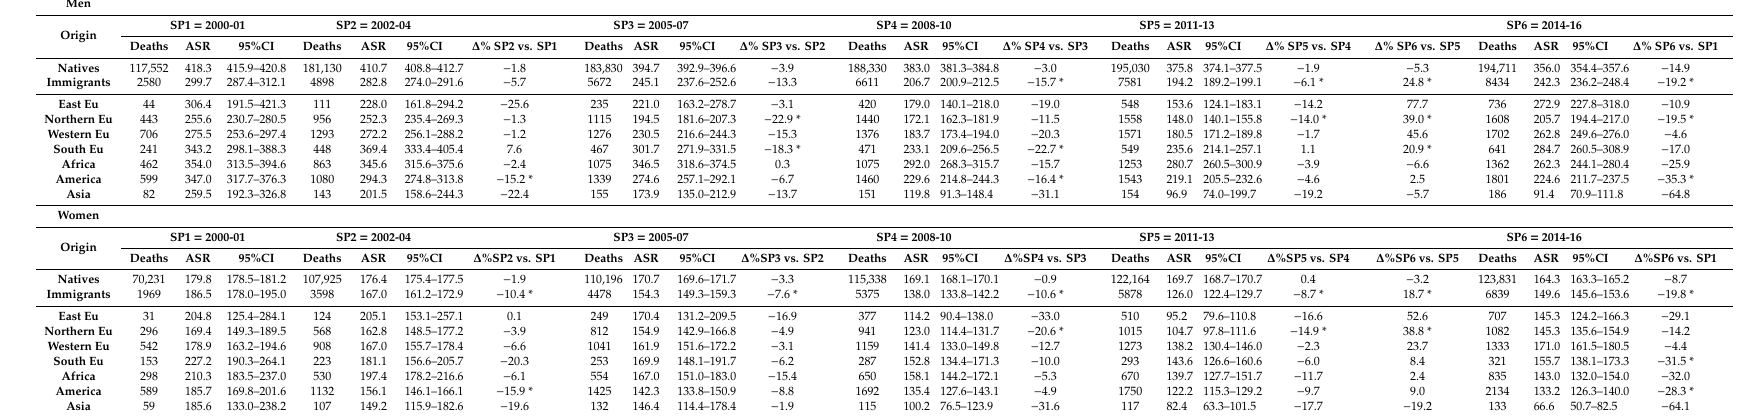
Table 1. Age-standardized rates of cancer mortality (ASR) per 100,000 people and percentages of change between immigrant and native populations for men and women by region of birth